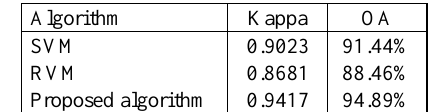
Figure 4. Classification results of RVM